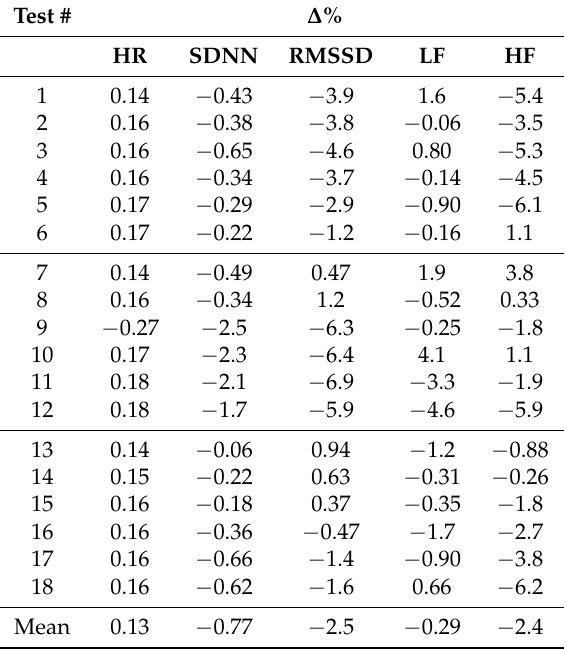
Table 2. Relative deviation between developed sensor and reference for principal HRV